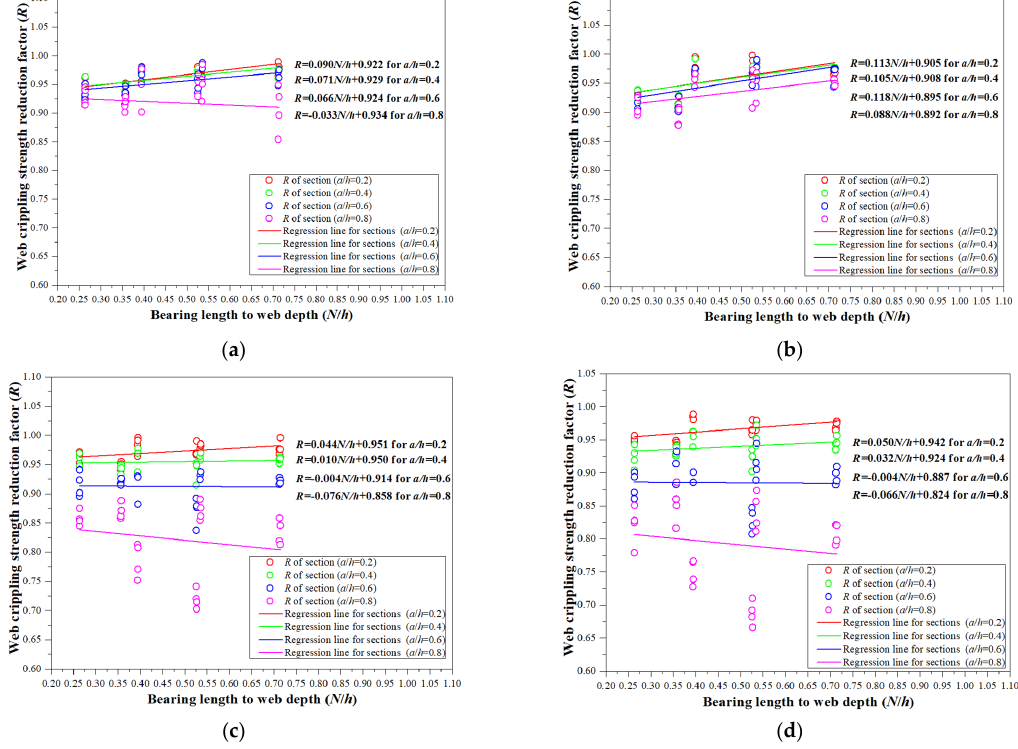
Figure 8. Web crippling strength reduction factor against N / h for cold-formed steel channel with ( a ) fastened flanges and offset web hole subjected to IOF at 200 ◦ C; ( b ) fastened flanges and offset web hole subjected to IOF at 600 ◦ C; ( c ) unfastened flanges and offset web hole subjected to IOF at 200 ◦ C; ( d ) unfastened flanges and offset web hole subjected to IOF at 600 ◦ C.